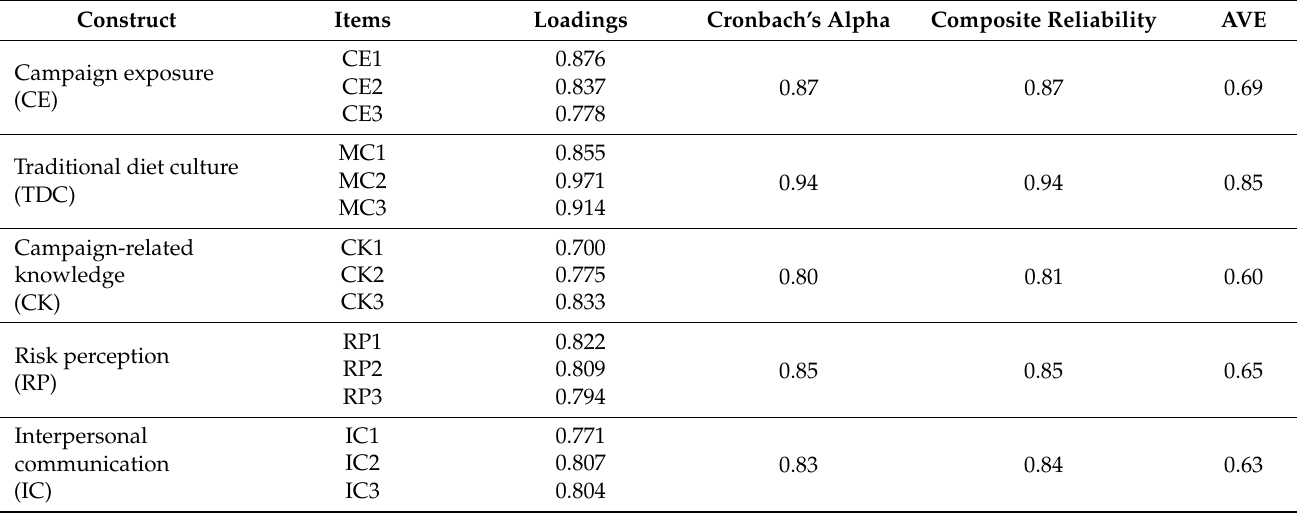
Table 4. Confirmatory factor analysis